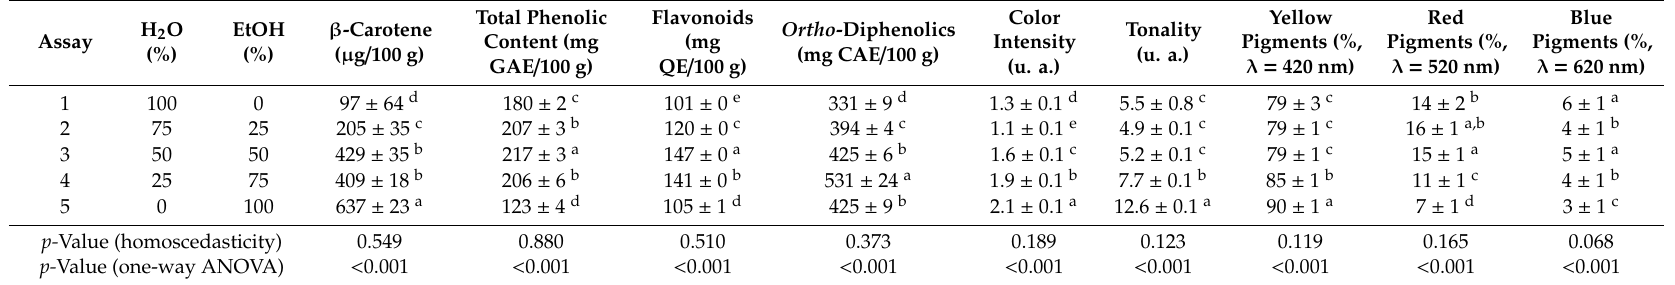
Table 3. Chemical composition and instrumental color of Calendula o ffi cinalis flower extracts.